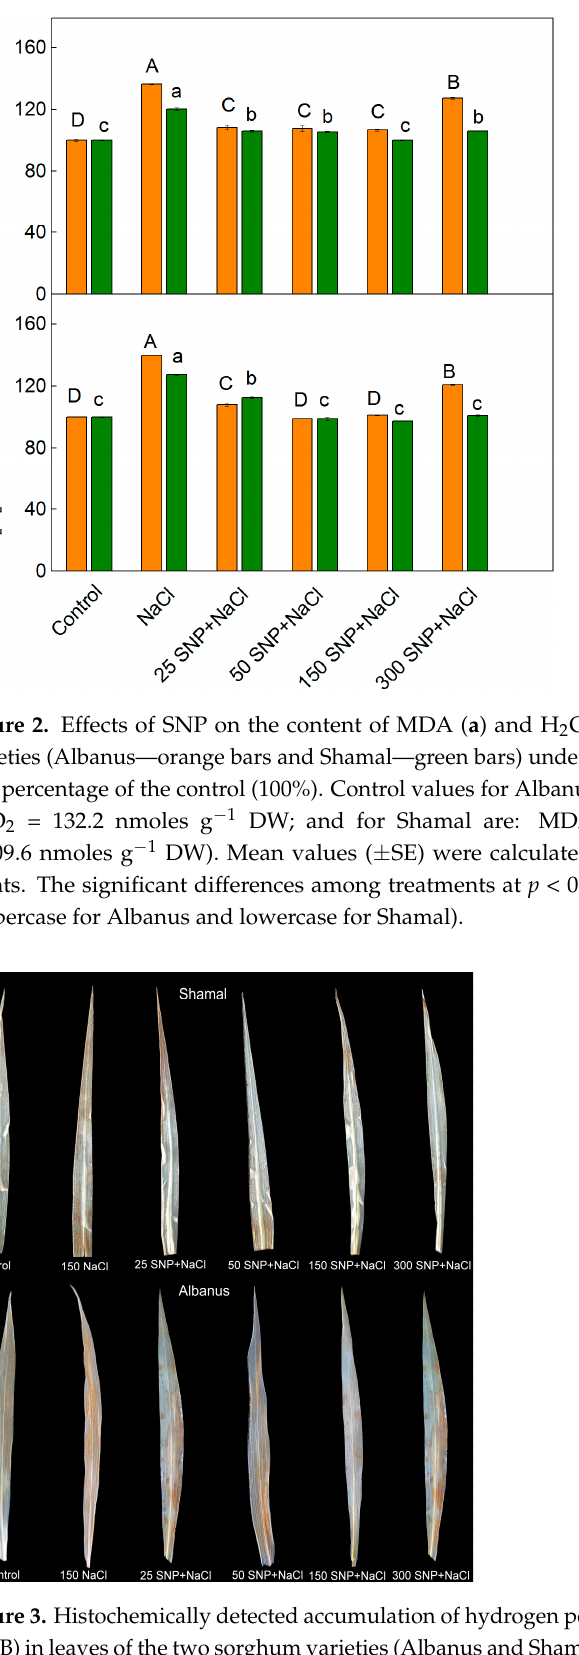
Figure 4. Injury index of leaves from the two sorghum varieties (Albanus—orange bars and Sha- mal—green bars) treated with 150 mM NaCl alone and after spraying with different concentrations of SNP (0–300 µM). Mean values (±SE) were calculated from eight independent measurements. The significant differences among treatments at p < 0.05 are indicated by different letters (uppercase for Albanus and lowercase for Shamal).